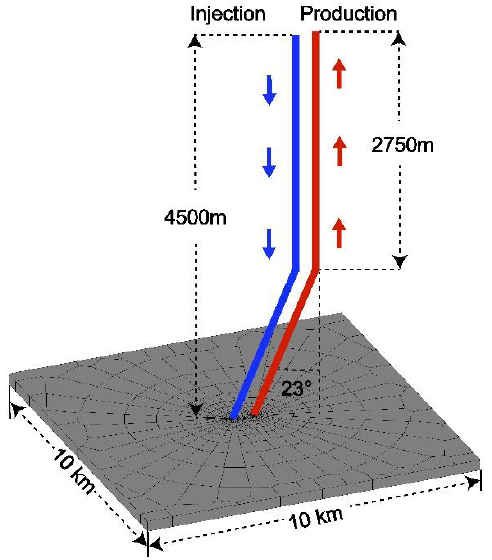
Figure 1. Sketch of the doublet supercritical geothermal system based on IDDP-2 (the reservoir thickness is 50 m).